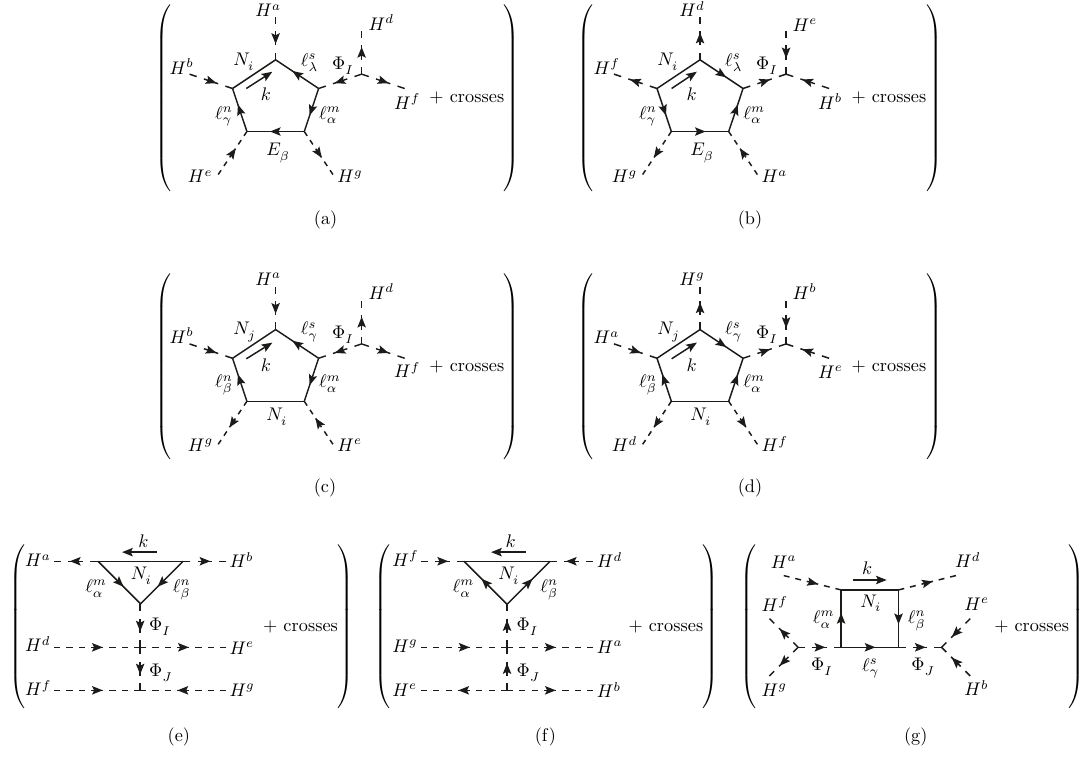
Figure 6 . The 1LPI diagrams with external lines generated by the (cid:0) H † H † H † HHH (cid:1) field config- uration in the type-(I+II) seesaw